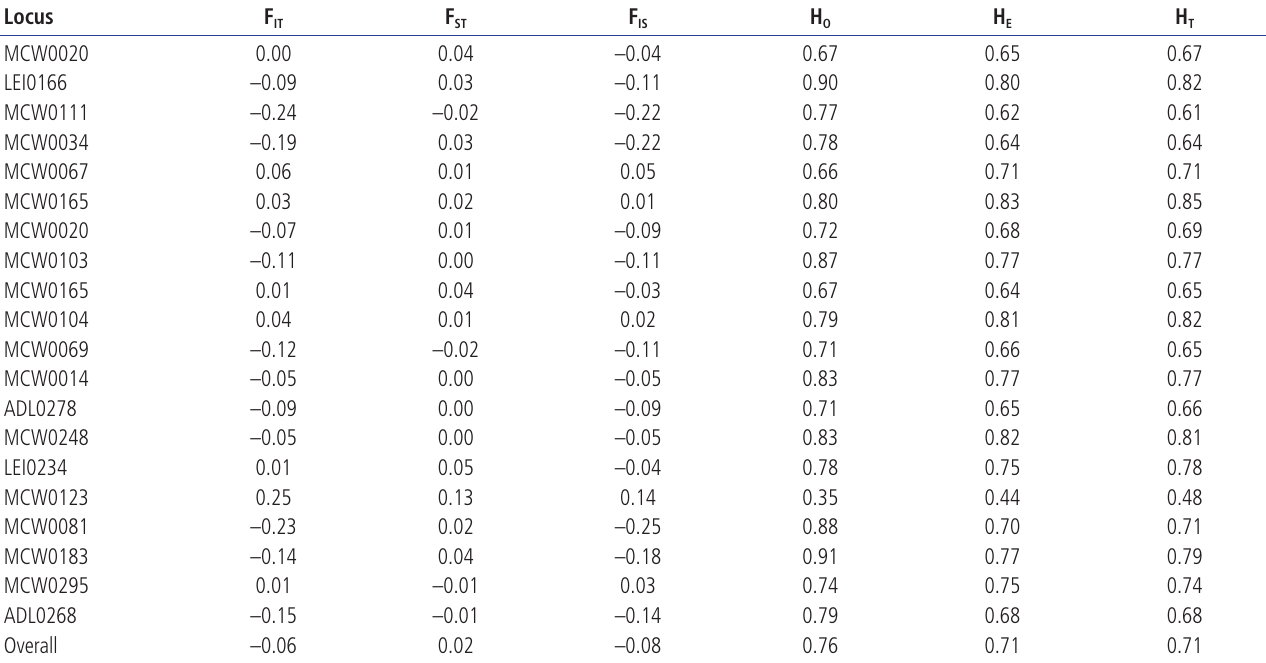
, F , and F ) and observed (H IT ST IS IT